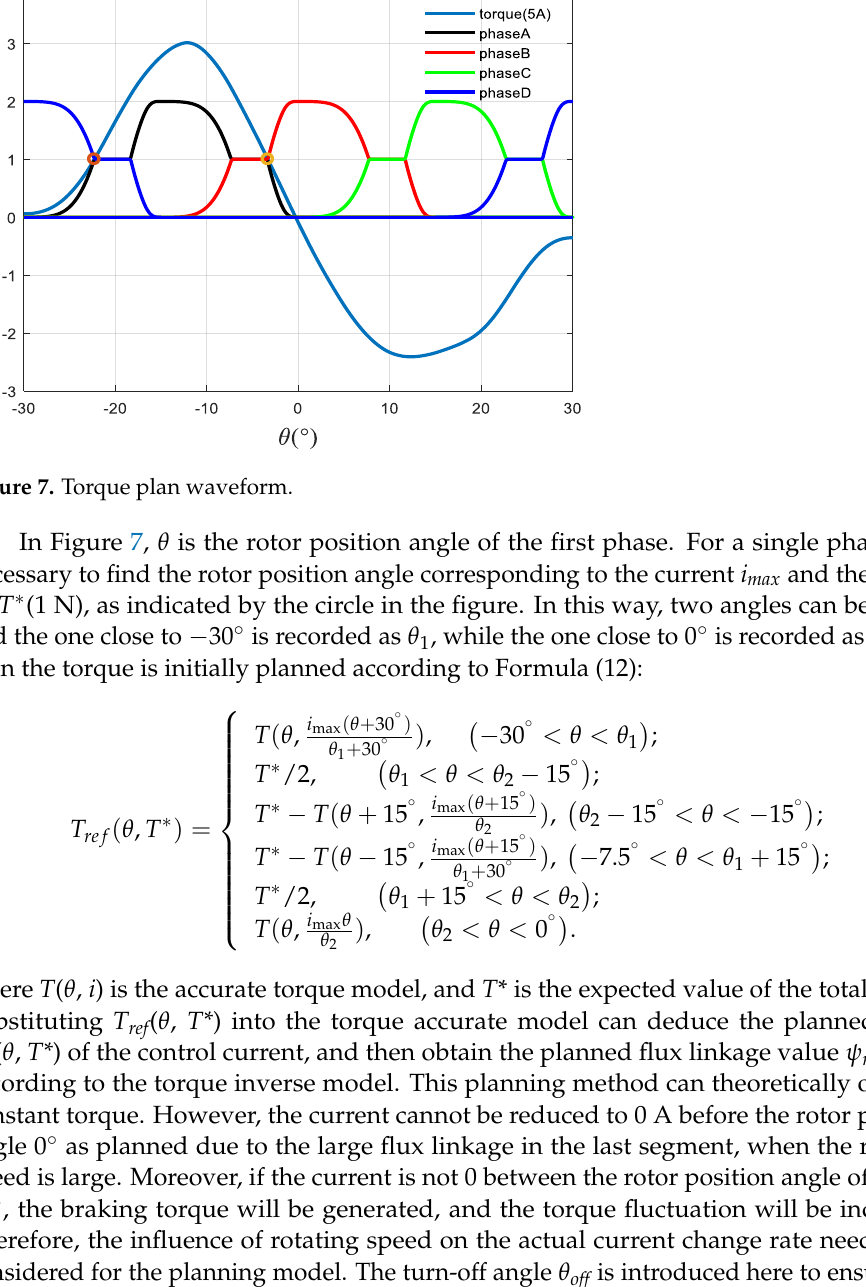
Figure 6. Relationship between memory and errors.